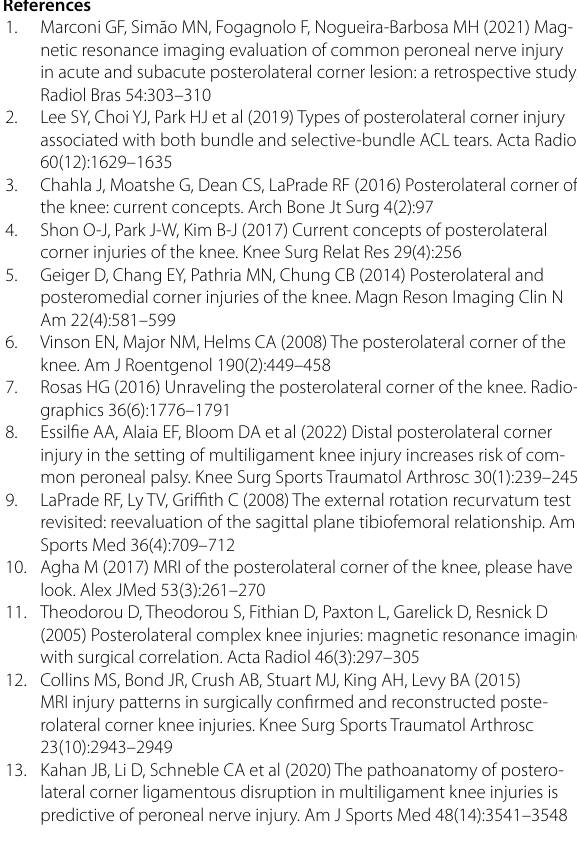
χ 2 chi-square test, FE Fisher’s exact, p p value for association between different categories, PPV positive predictive value NPV negative predictive